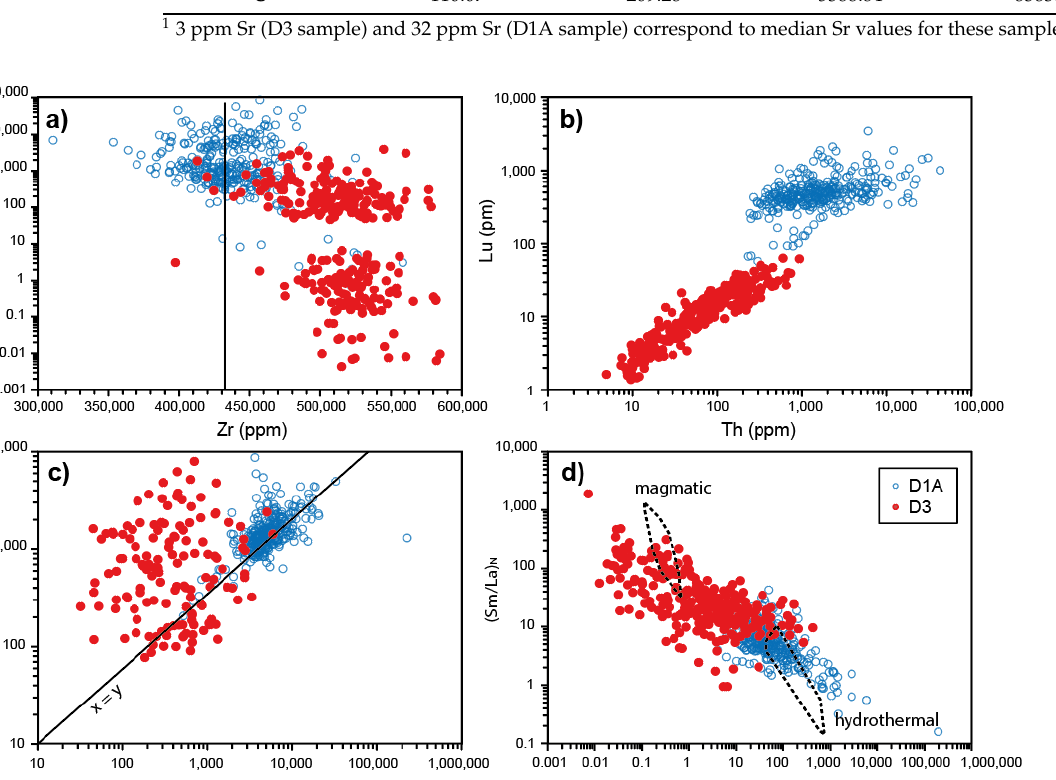
altered zircon from TTG intrusive suites, indicates that most of the studied zircons are altered, with grains from the D1A sample being the most altered (Figure 9d).